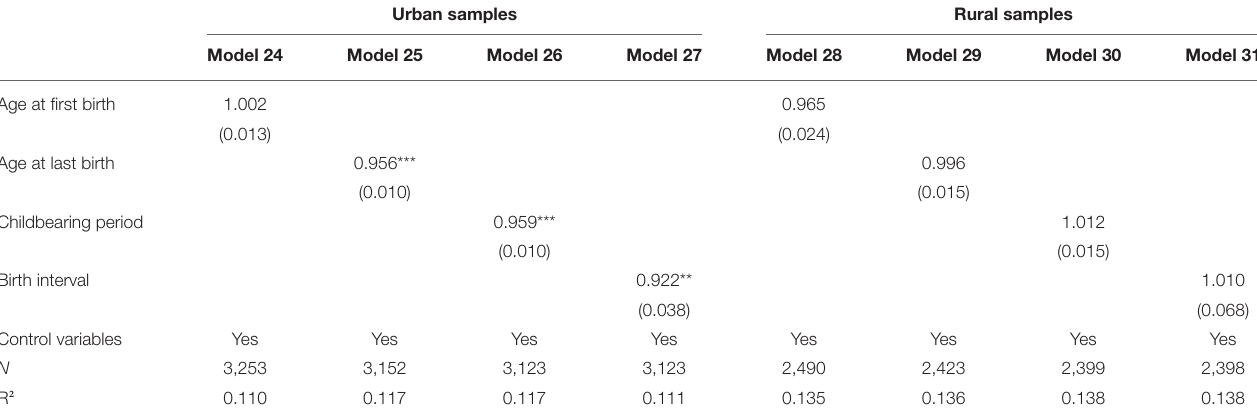
TABLE 10 | Estimates of urban–rural differences in the effects of other reproductive